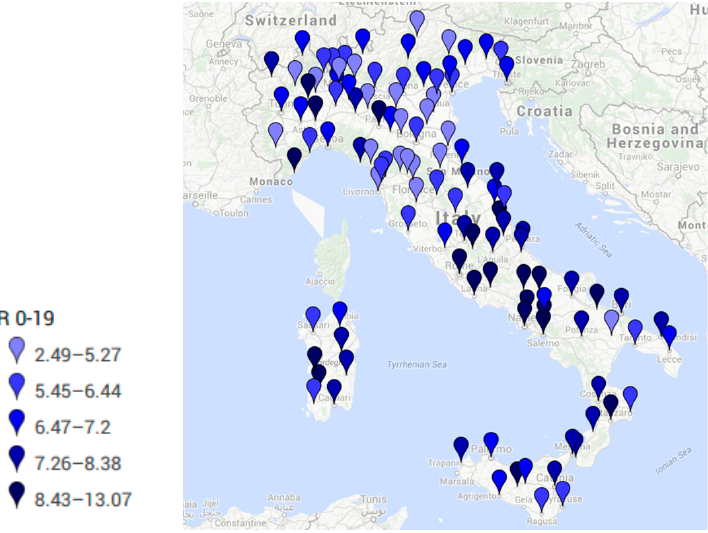
Figure 2. Standardized Hospitalization Rate (SHR) per 100,000 per each Italian province due to main diagnosis of cancer diagnosis of (all tumors) in pediatric population (0–19 years old).